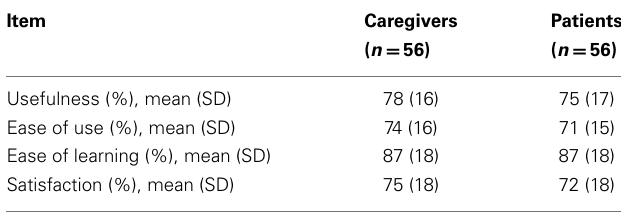
Table 4 | USE questionnaire scores for caregivers and patients